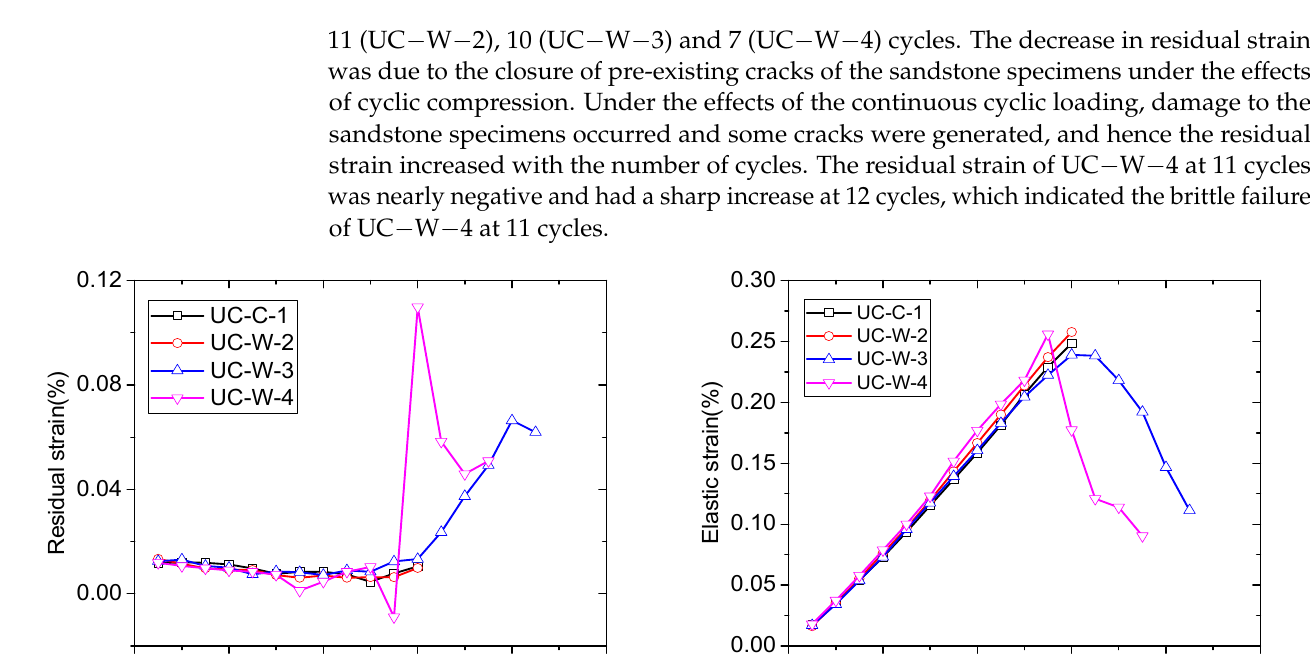
Figure 13. ( a ) Relationship between unloading stress and residual strain, and the ( b ) relationship between unloading stress and elastic strain.